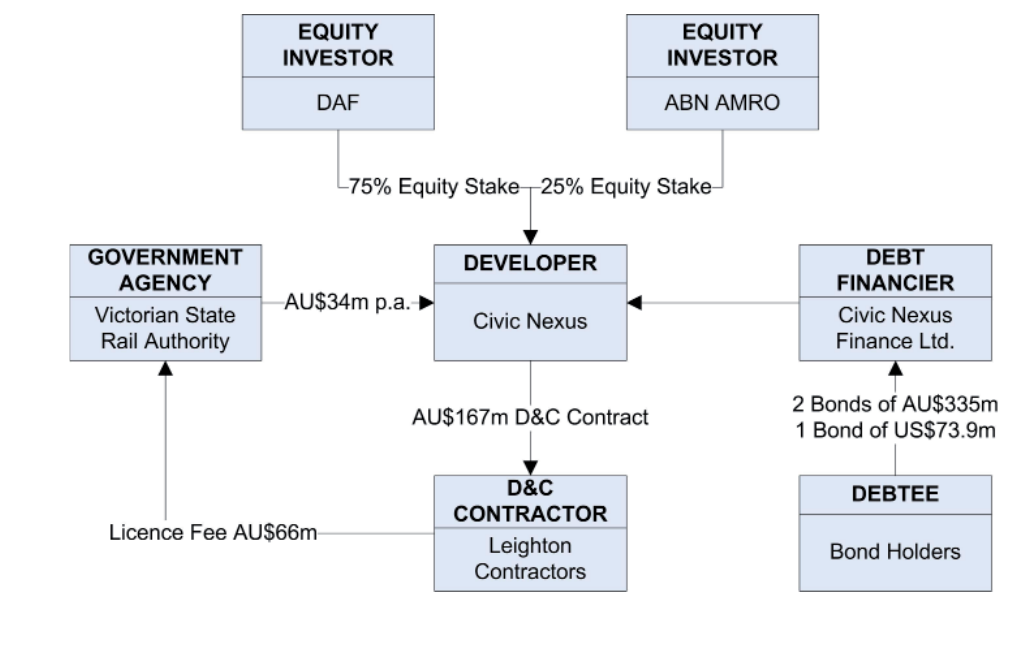
Figure 2: Financial structure of the Southern Cross Station redevelopment